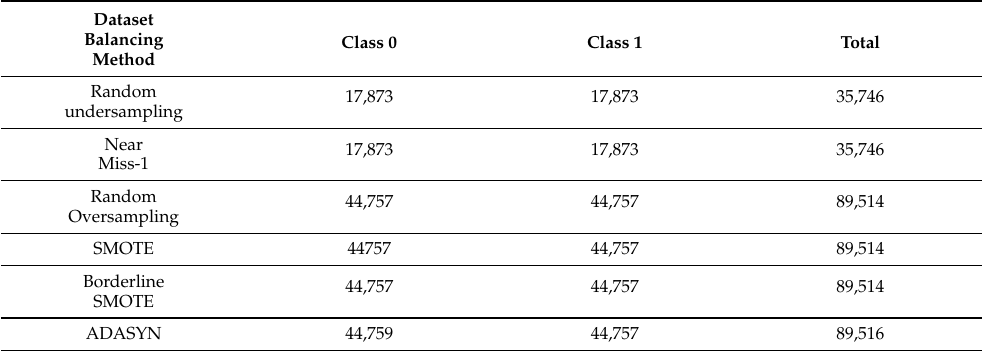
Table 4. The number of samples per class after application of various undersampling and oversam- pling methods on the original